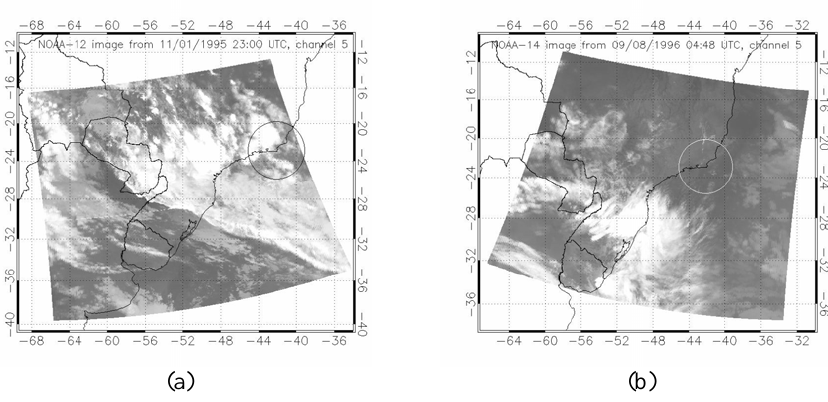
Fig. 2. NOAA satellite image for: (a) 10 January 1995, and (b) 9 August 1996. The circles indicate the location of the Cabo Frio region.